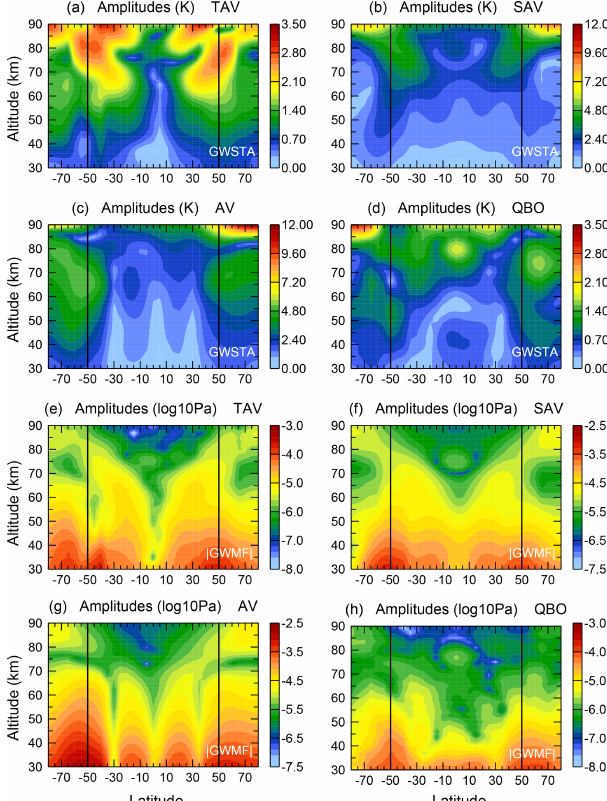
Figure 11. Altitude–latitude sections of spectral amplitudes for ter- annual, semiannual, annual and QBO variation obtained by sinu- soidal fits of the time series of the square root of monthly zonal mean GW square temperature amplitudes ( a–d , in kelvin) and GW absolute momentum flux ( e–h , in log10